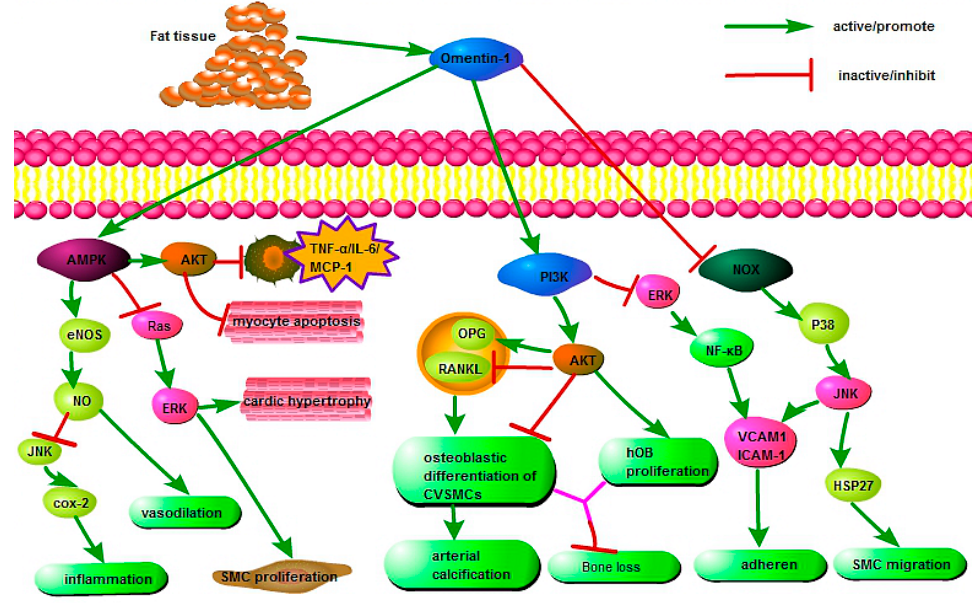
Figure 1. The protective mechanisms of omentin in various pathophysiological processes. AMPK, Adenosine 5 ′ -monophosphate (AMP)-activated protein kinase; eNOS, endothelial nitric oxide synthase; COX-2, cyclooxygenase-2; ERK, extracellular regulated protein kinases; TNF- α , tumor necrosis factor- α ; IL-6, interleukin-6; MCP-1, monocyte chemotactic protein-1; PI3K, phosphatidylinositol 3 kinase; AKT, protein kinase B; OPG, osteoprotegerin; RANKL, receptor activator for nuclear factor κ B ligand; CVSMC, calcifying vascular smooth muscle cells; VCAM-1, vascular cell adhesion molecule-1; ICAM-1, intracellular adhesion molecule-1; NOX, NADPH oxidase; JNK, Jun N-terminal kinase; HSP27, heat shock protein 27; SMC, smooth muscle cell; NF- κ B, nuclear factor- κ B.